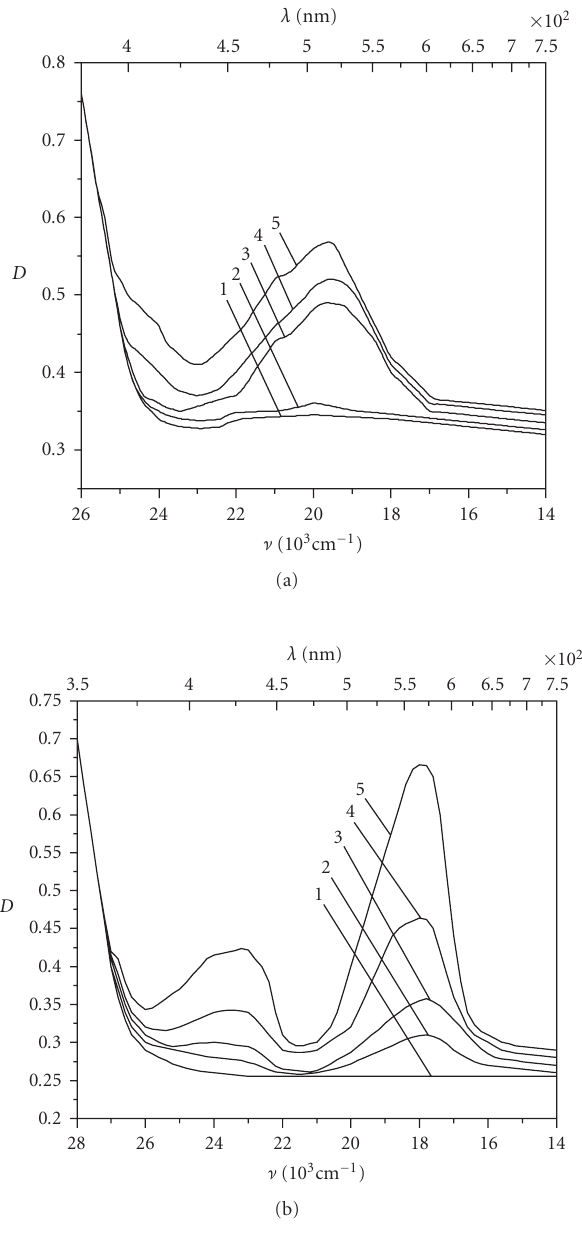
Figure 2: Absorption spectra of spiropyrans III (a) and IV (b). Spectra 1,2,3,4,5, were recorded after 0, 5,15,20,30 min irradiation,